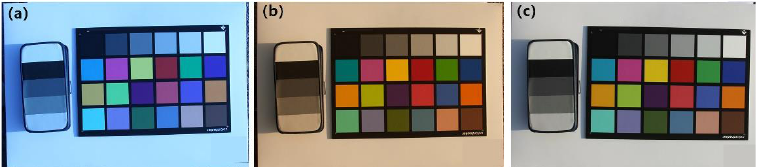
Figure 11. Photographs of color cards for color temperature assessment at 2500 K ( a ), 10,000 K ( b ), and using the automatic white balance function ( c ).